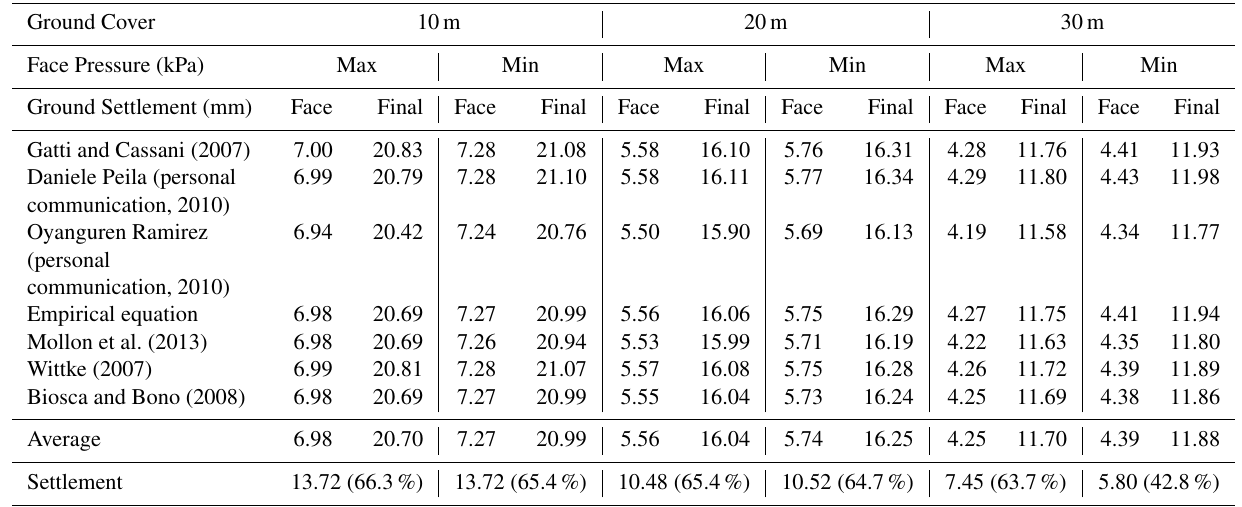
Table 3. Ground settlement according to face and backfill pressure (Case 5). Ground Cover